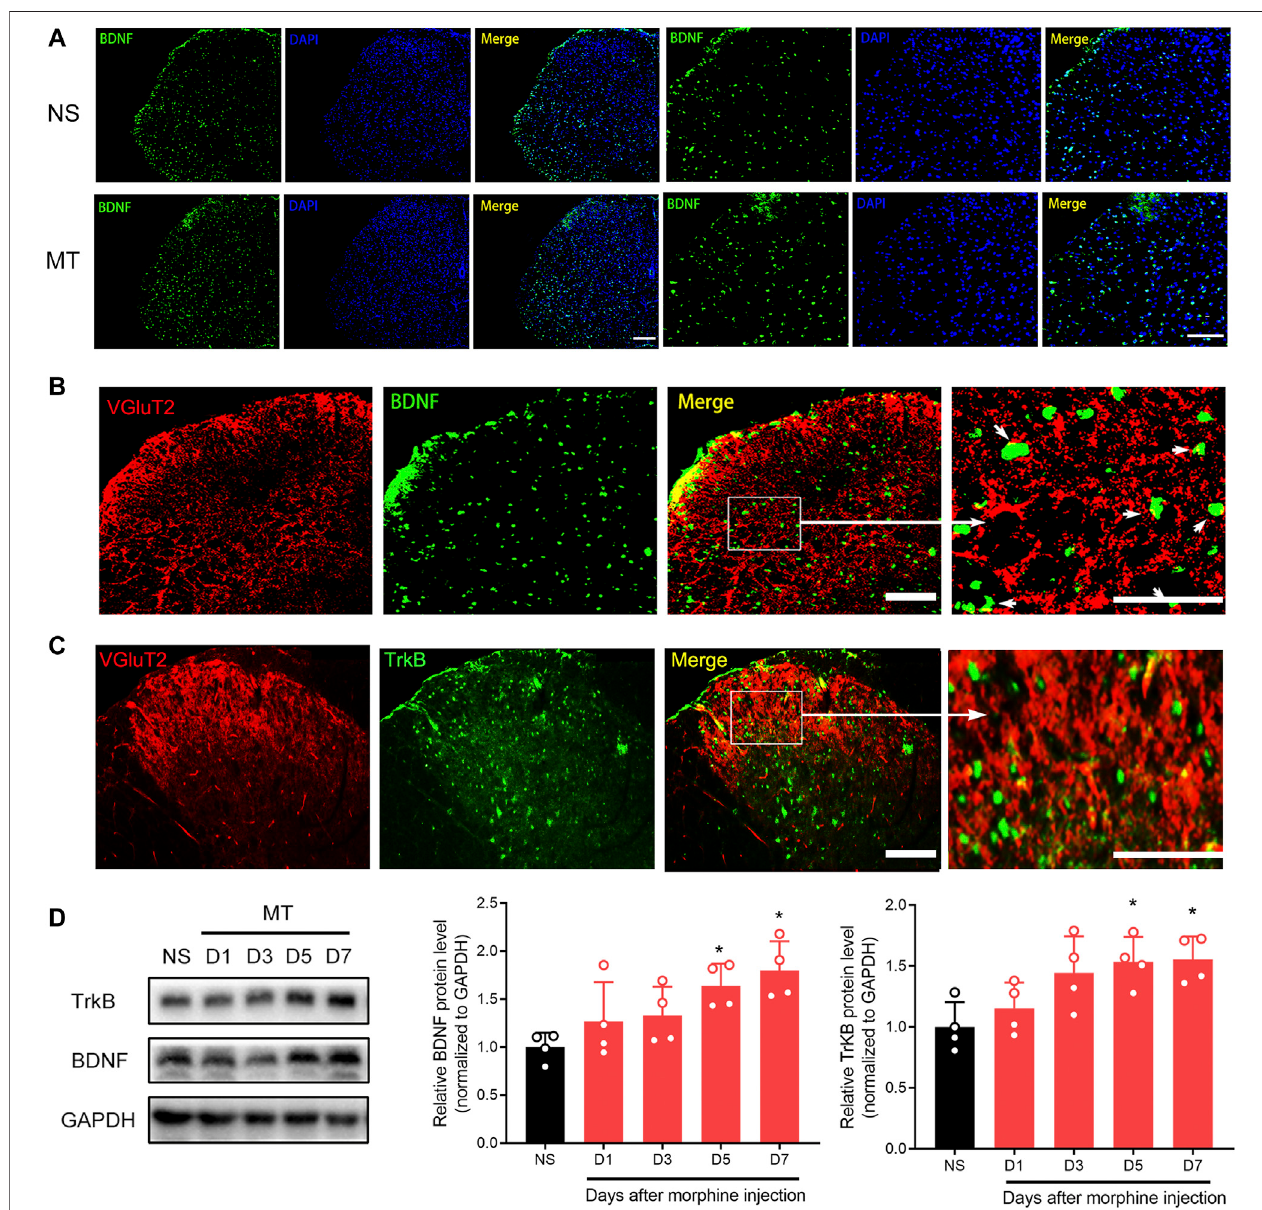
FIGURE 6 | Repeated administration of morphine increases BDNF and TrkB expression in the spinal cord (A) Representative immuno fl uorescent images showing BDNFisincreased7daysafterchronicmorphineadministration.n=4,Scalebars,100 μ m (B,C) Doubleimmuno fl uorescencestainingshowingBDNFandTrkBareco- expressed with VGluT2 in the spinal cord of the MT mice. n = 4, Scale bars, 100 μ m (D) Western blotting showing the time course of BNDF and TrkB in the spinal cord afterchronicmorphineadministration.n=4,one-wayANOVA(forBNDF)F(4,15)=4.669, p =0.0120(forTrkB)F(4,15)=4.808, p =0.0107.* p < 0.05compared with